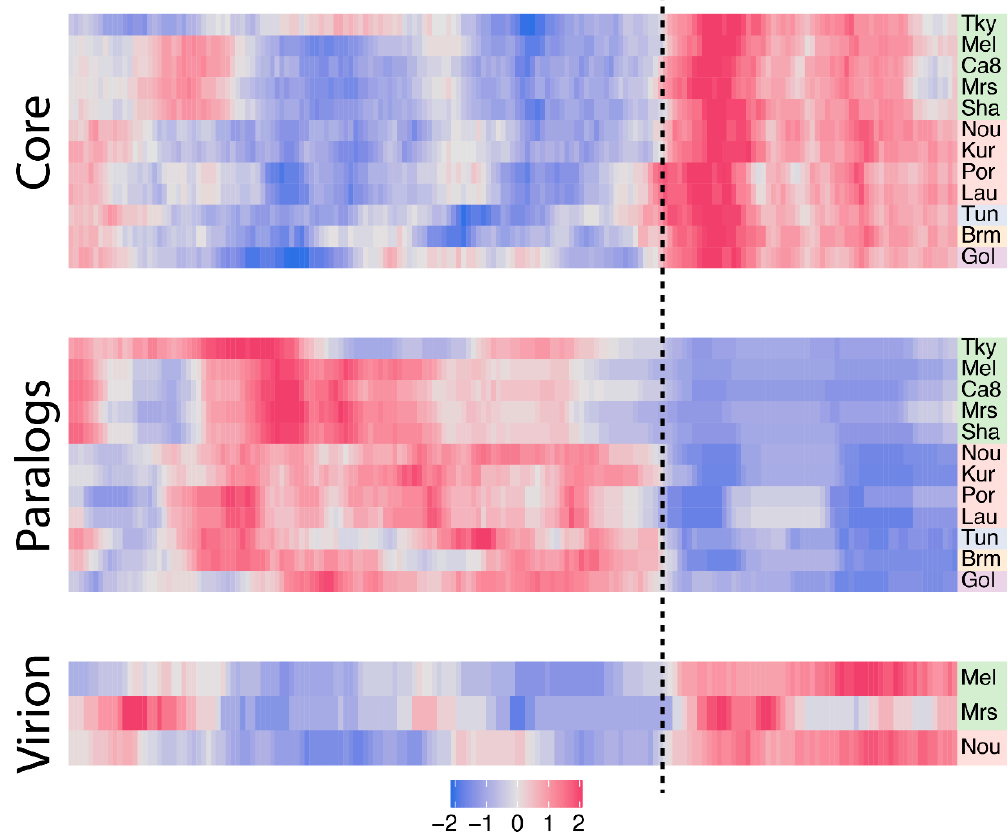
Figure 4. Density of core genes, paralogs and virion-associated protein-coding genes in marseilleviruses. Each row corresponds to a marseillevirus, namely: tokyovirus (Tky), melbournevirus (Mel), cannes 8 virus (Ca8), marseillevirus (Mrs), marseillevirus shanghai (Sha), noumeavirus (Nou), kurlavirus (Kur), port-miou virus (Por), lausannevirus (Lau), tunisvirus (Tun), brazilian marseillevirus (Brm) and golden marseillevirus (Gol). Strains are color-coded according to the clade they belong to, with A in green, B in red, C in blue, D in orange an E in purple. The z-score normalized density is color-coded from blue (low density) to pink (high density). The dash line separates the region of higher density in core genes, paralogs and virion-associated protein-coding genes.